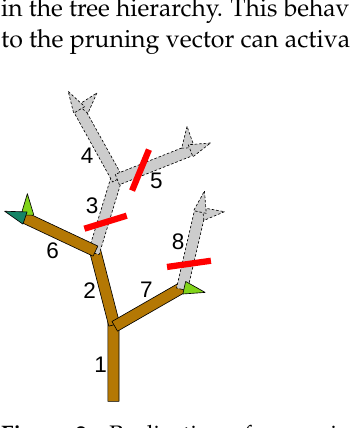
Figure 2. Realization of a pruning vector (i.e., genotype) x = (i.e., phenotype). In this example, the cut on internode 5 is deactivated by the cut on internode 3 up the tree